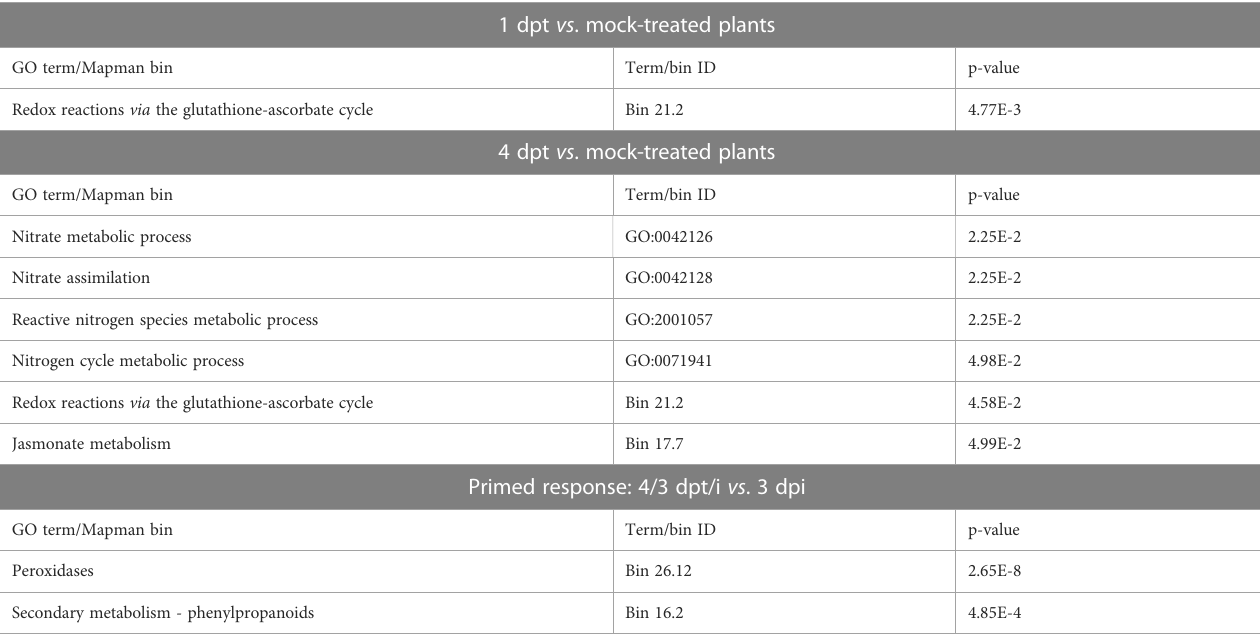
TABLE 1 Diproline-induced resistance in rice is associated with transcriptional induction of various defense-related compounds and pathways. 1 dpt vs . mock-treated